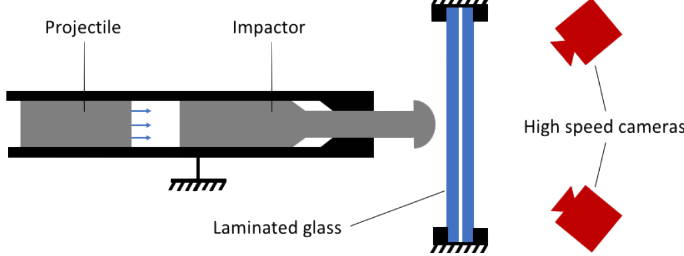
Fig. 4. Scheme of a “cannon” experiment. The impactor and projectile are guided in the barrel. Impactor axial movement is